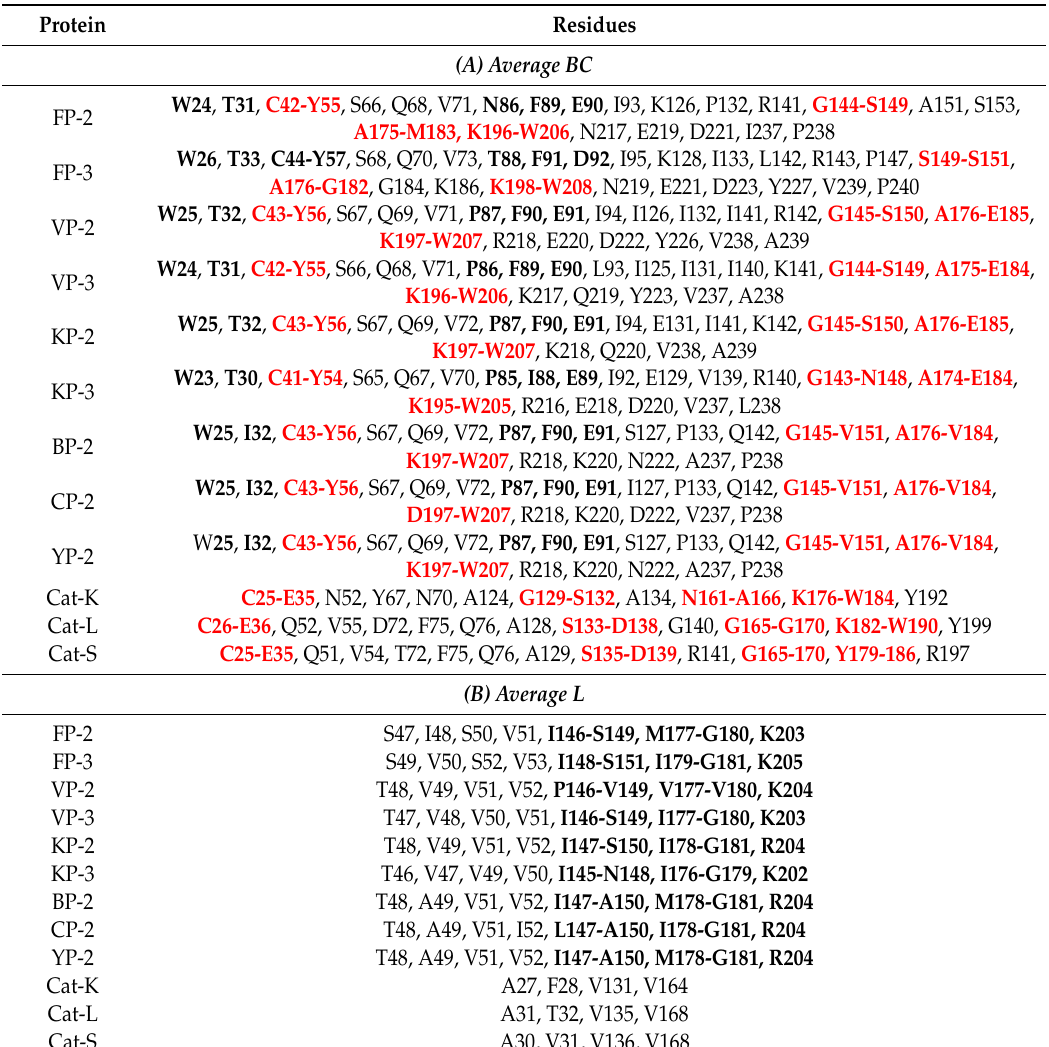
Table 3. Residues with high average BC values ( A ) and low average L ( B ) in both apo and ligand-bound systems. Residue numbering based on the catalytic domain length indicated in Table S1. Bold red shows cluster of residues with high BC values in both human and plasmodial proteins while bold black those only in plasmodial